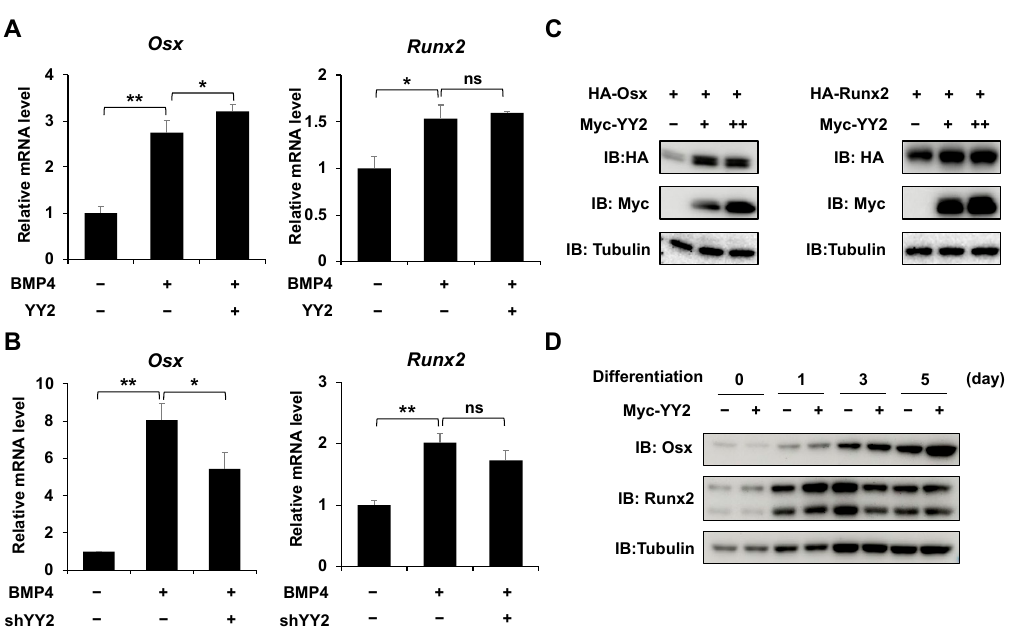
Figure 4. YY2 upregulates the expression of Osx. ( A ) Overexpression of YY2 increased the mRNA levels of Osx . YY2 or empty vector-transfected C2C12 cells were stimulated with or without BMP4 for 48 h. ( B ) Knockdown of YY2 decreased the mRNA levels of Osx . Knockdown of YY2 or shCon (pSuper vector) transfected C2C12 cells were stimulated with or without BMP4 for 48 h. The expression of Runx2 and Osx is compared by RT-qPCR. Data are expressed as mean ± SEM of at least three experiments. * p < 0.05, ** p < 0.01, and ns: non-significant. ( C ) Overexpression of YY2 increases the protein level of Osx. HEK293 cells were transfected with HA-Osx (left panel) or HA-Runx2 (right panel) and increasing amounts of Myc-YY2. After 48 h, the cell lysates were measured by Western blot. Tubulin was used as the loading control. ( D ) Overexpression of YY2 enhanced the protein levels of Osx during osteoblast differentiation. The numbers indicate the time points of differentiation induction. The targeted proteins were detected by western blotting.